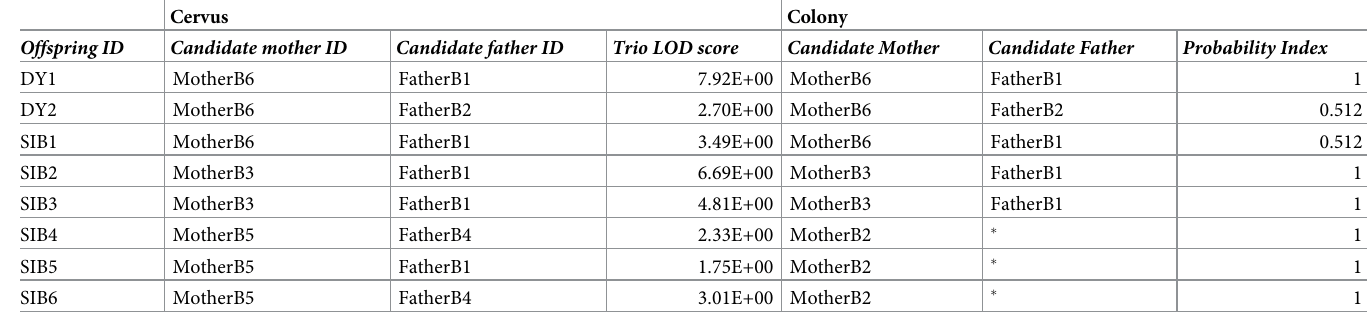
Table 3. Results of parentage assignment from Cervus and Colony for S . canicula . Trio log-likelihood ratio (Trio LOD score) is the probability of relationship between the offspring, mother and father. Probability Index = probability of family clusters. DY = Twin individuals, SI = possible sibling individuals. � = no genotype matched.